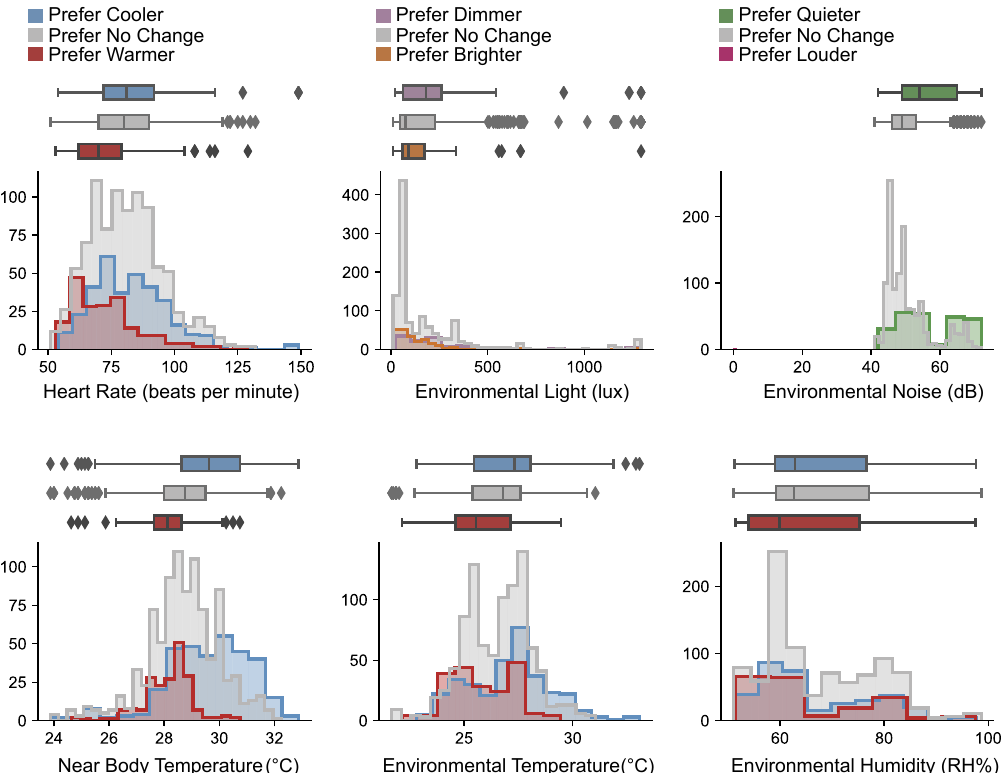
Figure 7. Distribution of sensor data by preference vote. While trends can be observed many feedback votes overlap for the same environmental or physiological measurement. This was possibly due to the different comfort tendencies as shown in Figure 5 or numerous other variables described in Figure 1 that are not accounted for. Near body temperature and noise appear to have the most distinct